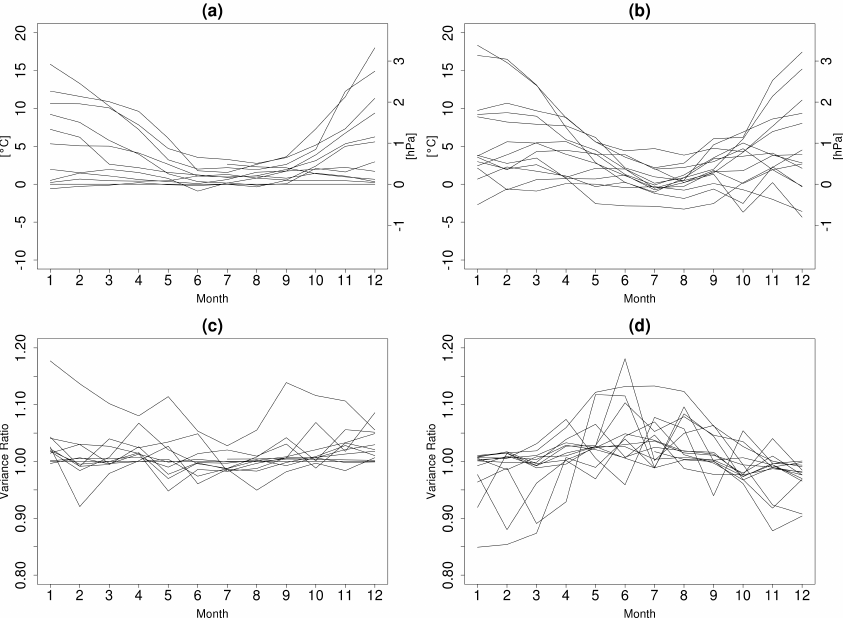
Figure 3. Panel (a) : monthly averages of the differences between temperature of the barometer and outside temperature for the stations where both are available. Panel (b) : monthly averages of the differences between temperature of the barometer and temperature climatologies from the Twentieth Century Reanalysis for the stations where the temperature of the barometer is available. In both panels the corresponding error in the pressure reduction to 0 ◦ C is shown on the right axis, calculated considering an uncorrected barometer reading of 760mm. Panel (c) : monthly ratios between the variance of pressure observations corrected using outside temperature and the same observations corrected using the temperature of the barometer, for the same stations as in (a) . Panel (d) : monthly ratios between the variance in pressure observations corrected using climatologies and the same observations corrected using the temperature of the barometer, for the same stations as in (b) . All plots are based on the period 1815–1817; climatologies are calculated for the period